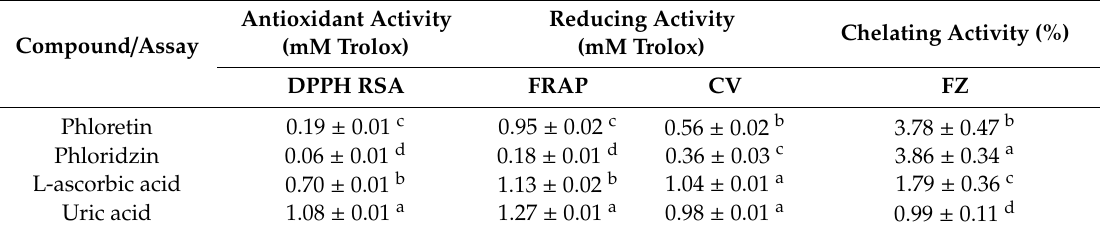
Table 2. The antioxidant, reducing and chelating activity of phloretin and phloridzin in comparison to L-ascorbic and uric acids.